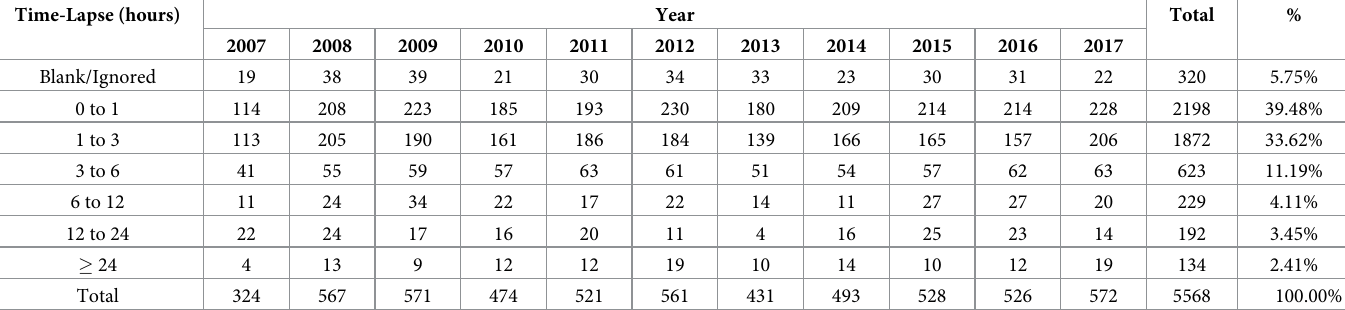
Table 2. The number of snake envenomations per time-lapse between envenomation and attendance in Mato Grosso Do Sul state, Brazil, between 2007 to 2017.